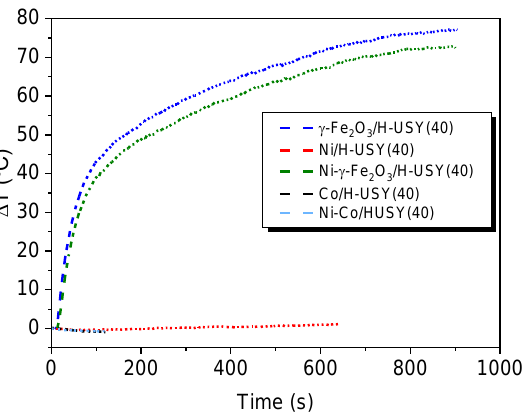
Figure 5. Induction heating curves (526 kHz) of H-USY(40) impregnated with γ -Fe 2 O 3 (Dark blue), Ni– γ -Fe 2 O 3 (Green), Ni (Red), Ni–Co mixture (Light blue) and Co